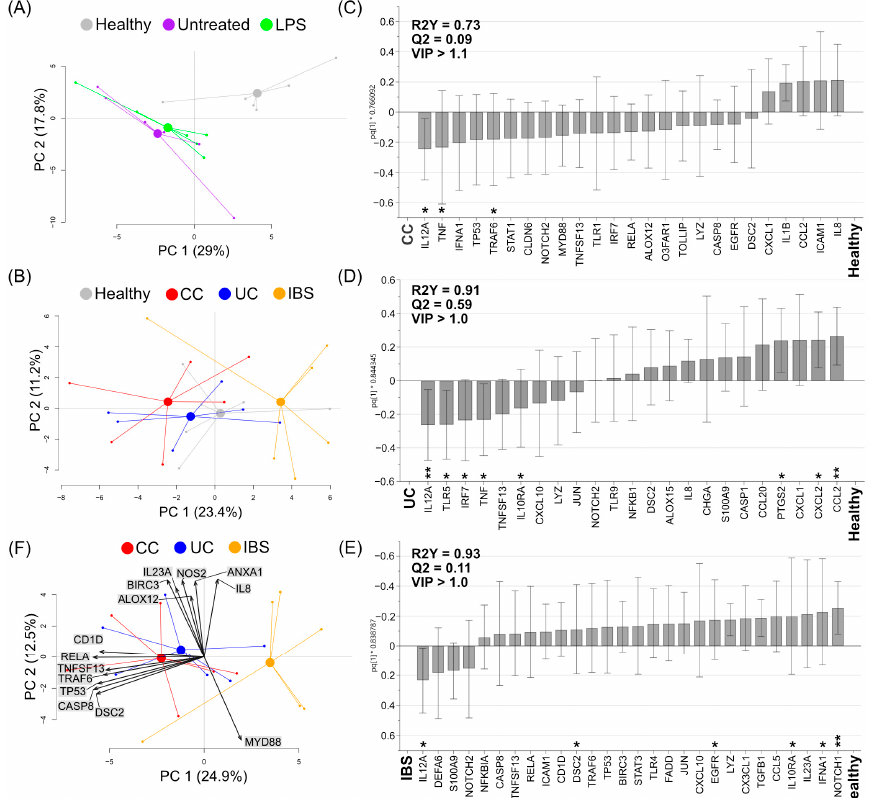
Figure 4. Gene expression of colonoids stimulated with fecal supernatants from healthy subjects and patients with colon cancer (CC), ulcerative colitis (UC) and irritable bowel syndrome (IBS). Apical-out colonoids were stimulated with fecal supernatants, LPS or left untreated (media) for 48 h. Gene expression was analyzed by a custom PCR array. ( A ) Principal component analysis (PCA) for colonoids treated with fecal supernatants from healthy subjects (grey), LPS (green), and media (purple). ( B ) PCA for colonoids treated with fecal supernatants from healthy subjects (grey) and CC (red), UC (blue) and IBS (orange) patients. Column loading plots from orthogonal partial least squares discriminant analyses (OPLS-DA) using a VIP cut-off > 1.0 or > 1.1, comparing ( C ) healthy subjects and patients with CC, ( D ) healthy subjects and patients with UC and ( E ) healthy subjects and patients with IBS. ( F ) A PCA biplot for colonoids stimulated with fecal supernatants from CC (red), UC (blue) and IBS (orange) patients. Between-group comparisons were tested with Mann–Whitney U test; asterisks identify statistically significant p values: * p < 0.05; ** p < 0.01. LPS (n = 6), media (n = 6); fecal supernatants (n = 6 for each group). LPS, lipopolysaccharide; CC, colon cancer; UC, ulcerative colitis; IBS, irritable bowel syndrome; PC, principal